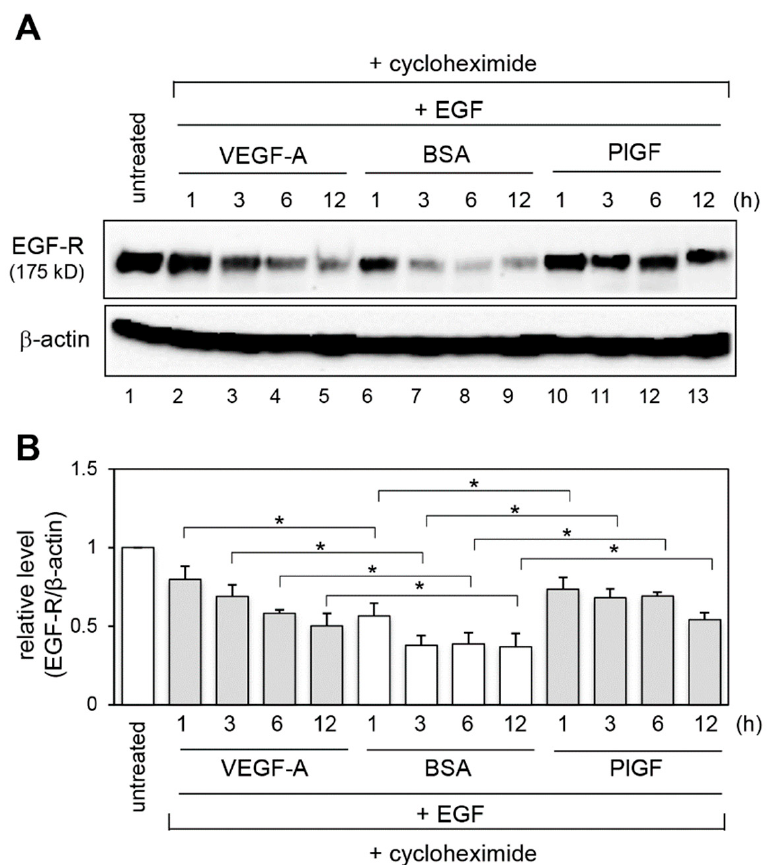
Figure 3. VEGFR-1 activation stabilizes EGF-R. ( A ) Cells were pretreated with control BSA, VEGF-A or PlGF for 1 h, then incubated with EGF plus cycloheximide for the indicated times. EGF-R protein levels were determined by immunoblot analysis. The levels of β -actin are shown as a loading control. ( B ) Quantification of EGF-R levels normalized to β -actin from three independent experiments. * p < 0.01, statistically significant increase compared with the BSA-treated control cells at the corresponding each time point.